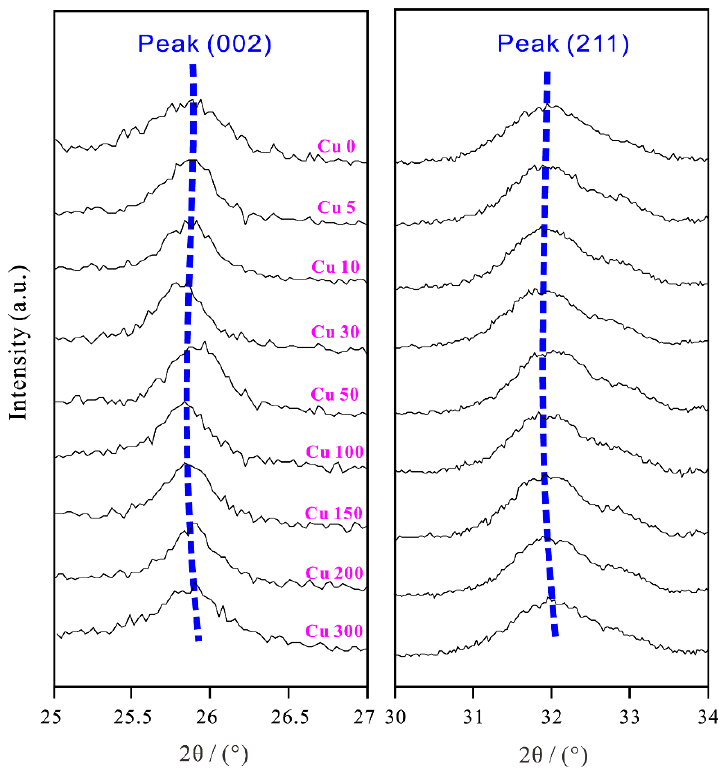
Figure 2. Shift of the (211) and (002) diffraction peaks of SC–HA/C after Cu (II) removal.